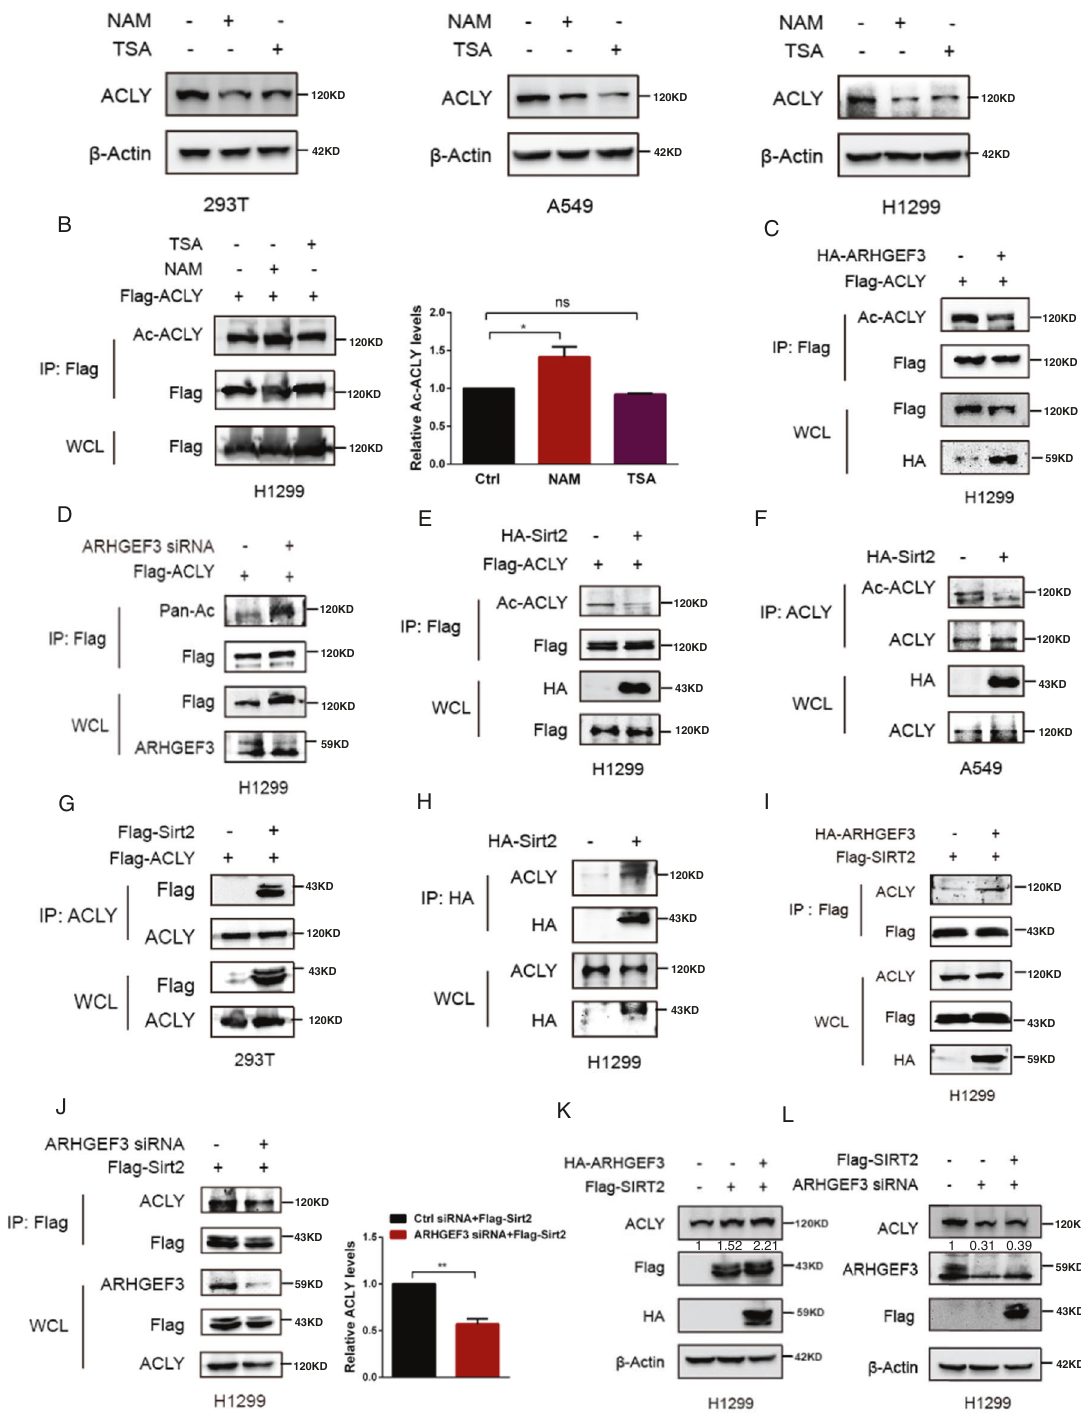
Fig. 3 ARHGEF3 enhances the interaction between ACLY and SIRT2. A Western blot was used to detect ACLY protein levels after NAM and TSA treatment. B Western blot was used to detect ACLY acetylation levels after NAM and TSA treatment (left). Quantitative analysis of ACLY protein level (right). The results represent the average of three independently repeated experiments (mean ± SD), ns no signi fi cance, * P < 0.05. C Western blot was used to detect the ACLY acetylation after ARHGEF3 overexpression. D Western blot was used to detect the ACLY acetylation after ARHGEF3 knockdown. E , F Western blot was used to detect the effect of SIRT2 on ACLY acetylation. G , H HEK293T and H1299 cells were transfected with indicated plasmids and immunoprecipitation was performed to detect SITR2-ACLY interaction. I Western blot was used to detect the in fl uence of overexpression of ARHGEF3 on SIRT2-ACLY interaction. J Western blot was used to detect the in fl uence of ARHGEF3 knockdown on SIRT2-ACLY interaction (left). Quantitative analysis of ACLY protein level (right). The results represent the average of three independently repeated experiments (mean ± SD), ** P < 0.01. K Western blot was used to detect the in fl uence of overexpression of ARHGEF3 and SIRT2 on ACLY protein level. L Western blot was used to detect the in fl uence of ARHGEF3 knockdown and SIRT2 on ACLY protein